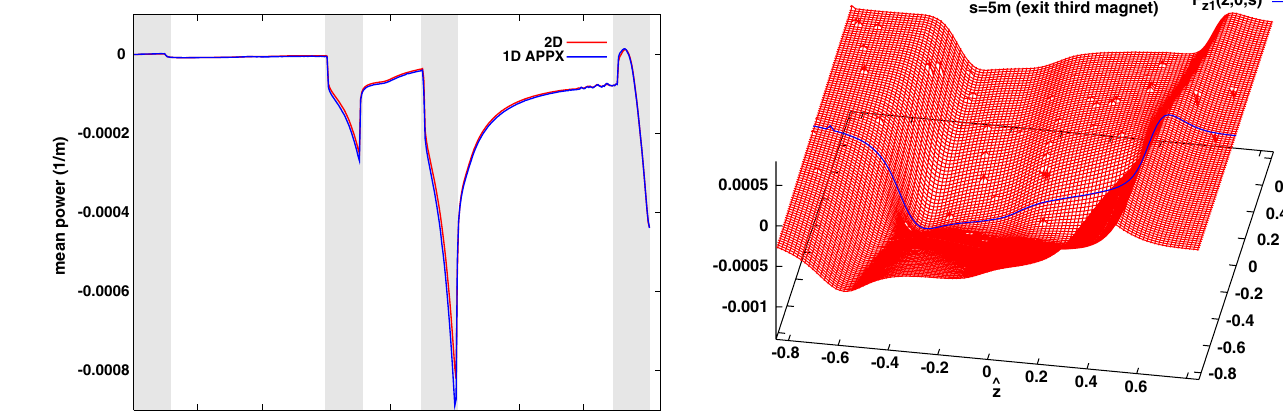
ð ~ z; ~ x; s Þ in normalized coordinates at FIG. 18. Plot of F z 1 s ¼ 5 m (exit third magnet) of the FERMI@Elettra first bunch ð ~ z; 0 ; s Þ compressor. The 1D field approximation scheme uses F z 1 (blue line). It is evident here that the 1D field approximation scheme is considerably faster than the 2D calculation as it reduces the computational cost by a factor proportional to the number of grid points in ~ x